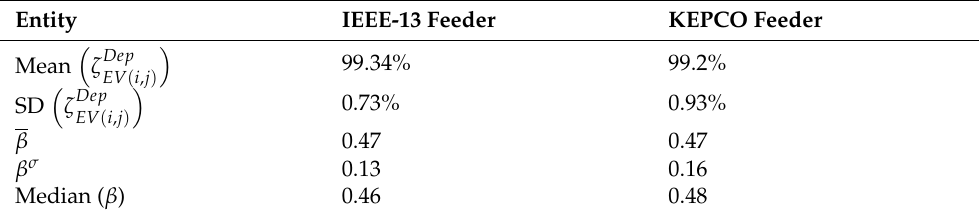
Figure 9. Indices comparison on IEEE 13-node distribution feeder and KEPCO X S/S-Z D/L feeder. Table 5. State of charge (SoC) and battery cycle usage results for IEEE 13-node distribution feeder and KEPCO X S/S-Z D/L